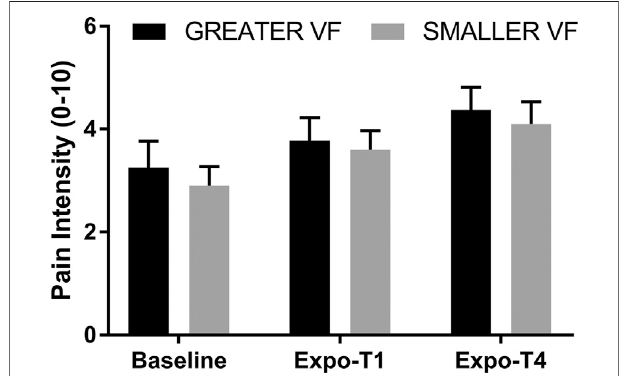
FIGURE 4 | Pain Intensity at Baseline, Expo-T1 and Expo-T4 for the GREATER and SMALLER visual feedback (VF). Error bars represent the standard error of the